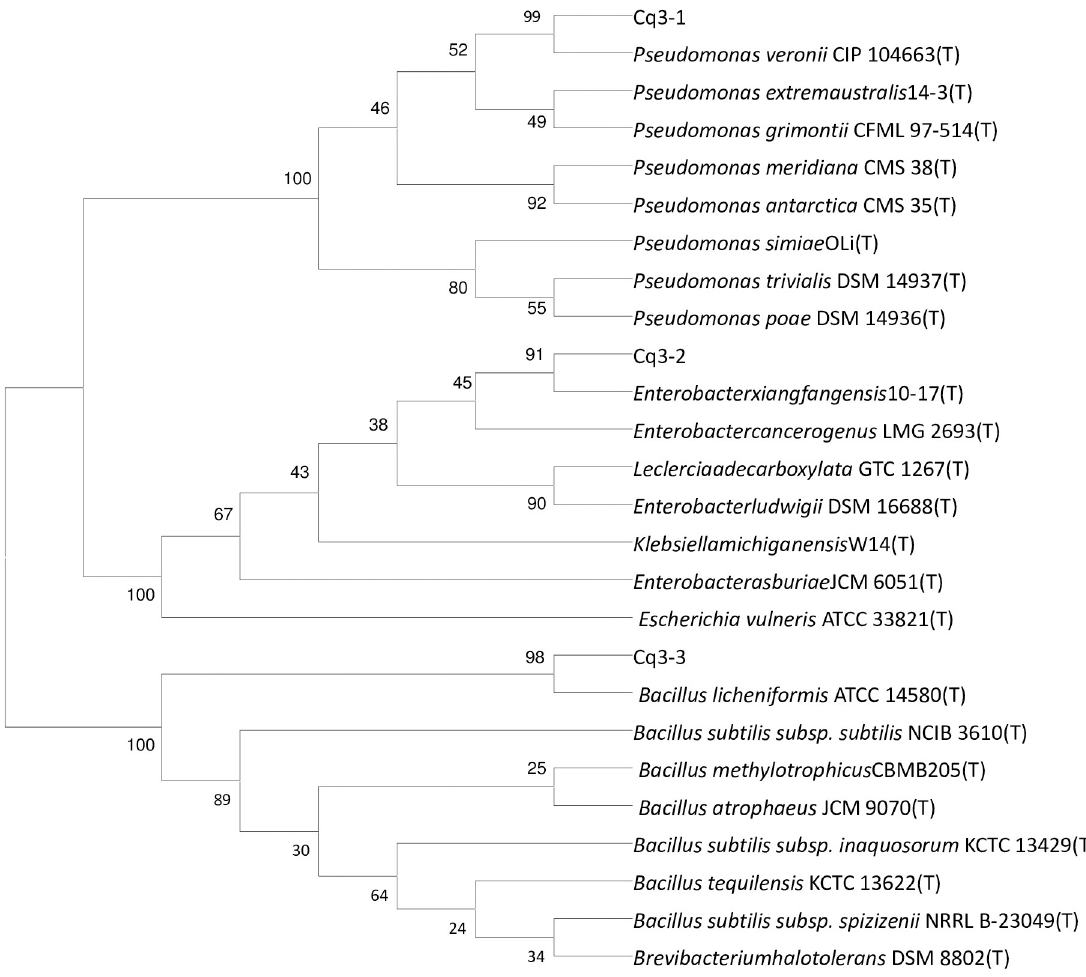
compounds as a carbon source. It uses two main methods for microbial sugar fermentation, one of which leads to mixed organic acids such as formic acid, acetic acid, and succinic acid as its final products. The third strain was Bacillus licheniformis , which is a typical facultative anaerobe. This strain tends to be strongly temperature resistant as well as alkali and acid proof. Of the three bacterial strains, Enterobacter multiplies rapidly under hypoxic condi- tions, whereas Pseudomonas and Bacillus licheniformis multiply rapidly under an oxygen- rich atmosphere.